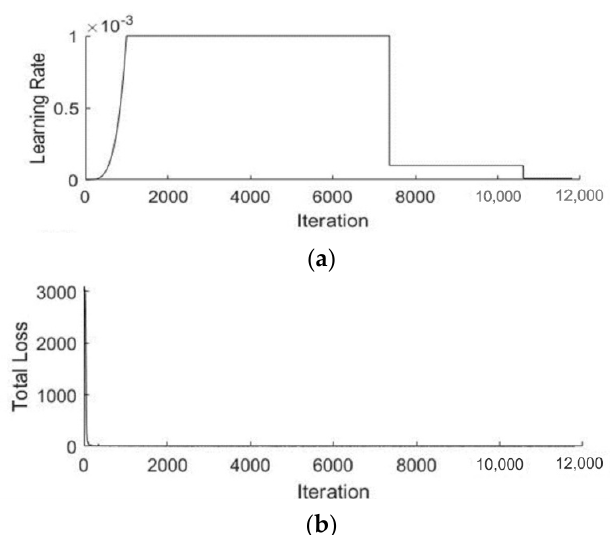
Figure 8. The training performance of the proposed YOLOv3-ResNet-50 model ( a ) Learning rate ( b ) Total loss.